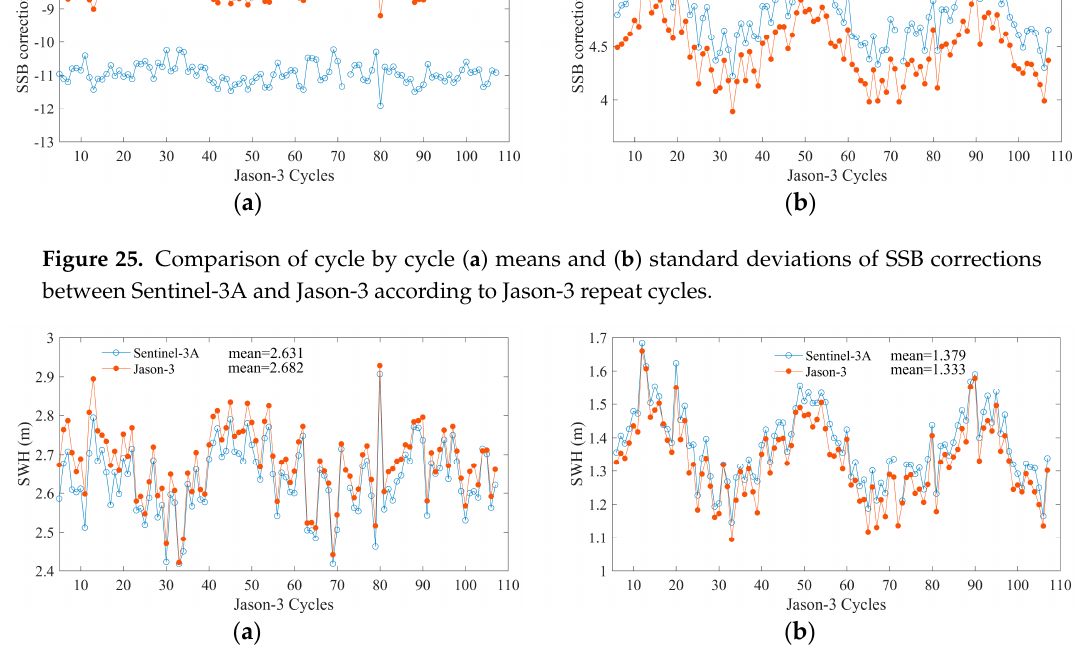
Figure 26. Comparison of cycle by cycle ( a ) means and ( b ) standard deviations of SWHs between Sentinel-3A and Jason-3 according to Jason-3 repeat cycles.